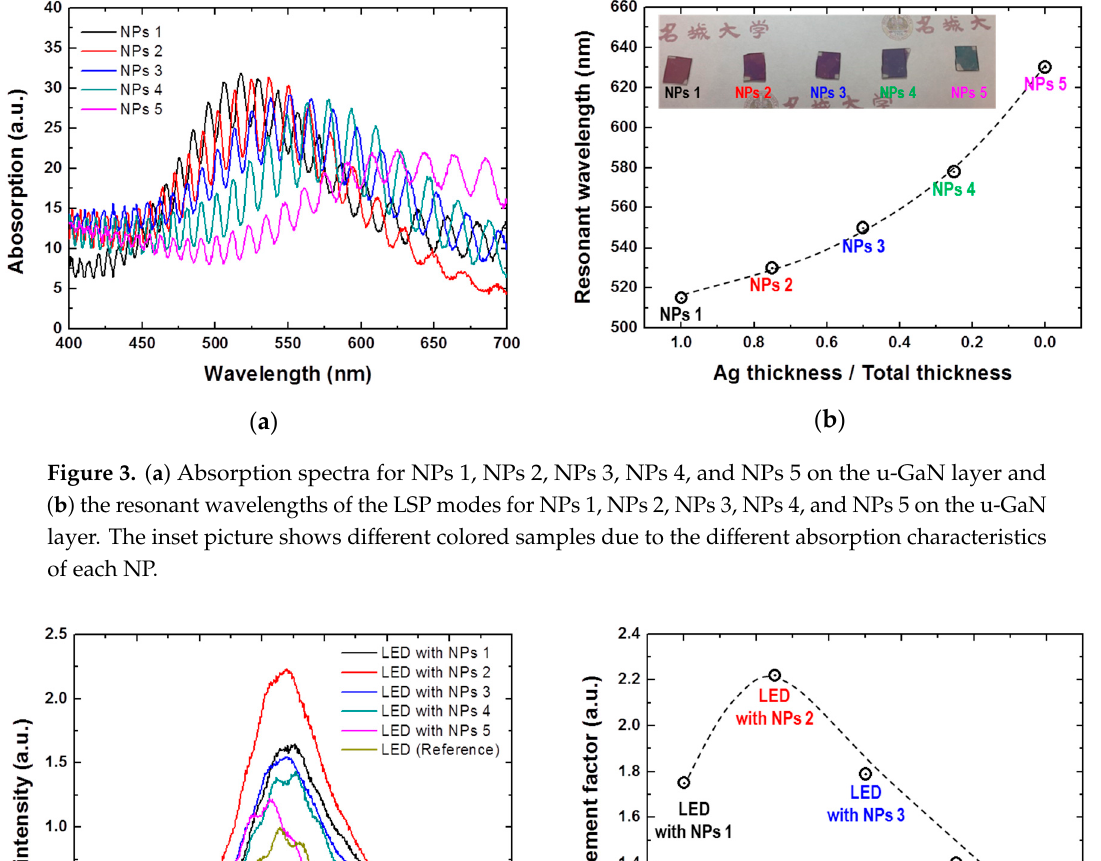
Figure 2. Top view SEM images of ( a ) NPs 1 on the u-GaN layer, ( b ) NPs 2 on the u-GaN layer, ( c ) NPs 3 on the u-GaN layer, ( d ) NPs 4 on the u-GaN layer, and ( e ) NPs 5 on the u-GaN layer.